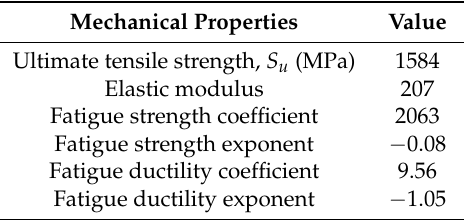
Figure 5. Data acquisition system. Table 1. Cyclic properties of Carbon Steel SAE